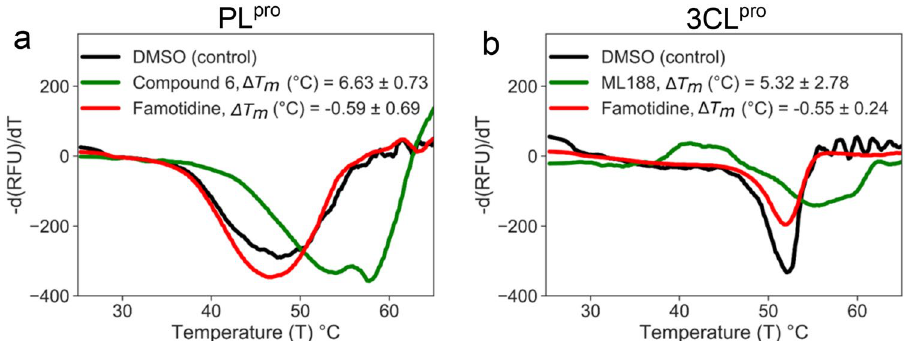
Figure 3. DSF assays of famotidine binding to PL pro and 3CL pro . Fluorescence-monitored thermal denaturation assay showing the melting curve (first-derivative of dissociation) for each of the two proteins (7 μM) in the presence or absence of compounds (2.5 mM) . ( a ) PL pro melting curves for DMSO control (black), compound 6 (green) and famotidine (red) show that while compound 6 stabilizes the PL pro ΔT m by 6.6 °C, famotidine is unable to shift the ΔT m. Similarly, in ( b ) while ML188 (green) stabilizes 3CL pro ΔT m , by 5.3 °C, famotidine (red) does not shift the melting temperature of 3CL pro . The values are mean ± standard deviation of three independent